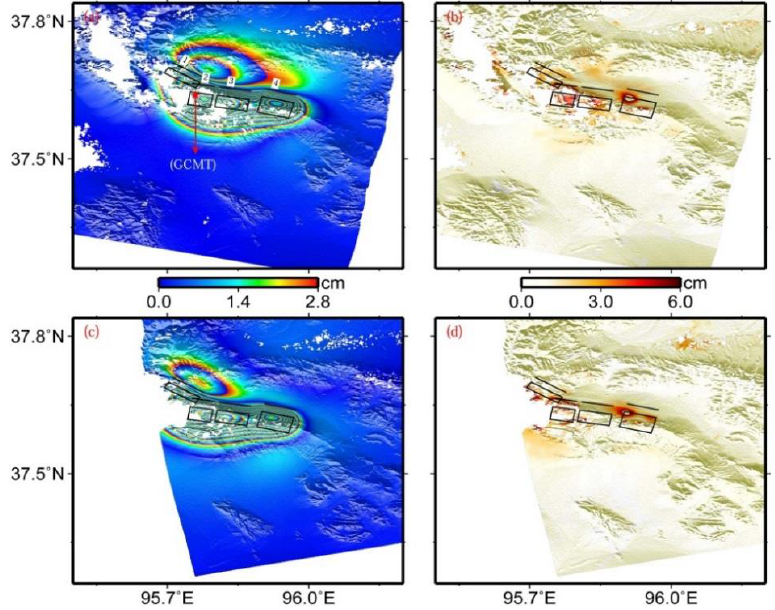
Figure 4. Modeled ( a ) and residual ( b ) interferograms predicted by uniform slip on four rectangular dislocations in an elastic half-space in the viewing geometry for the descending track T319, ( c , d ) for the ascending track T455. From the northwest to the southeast, four black rectangles denote the surface projections of faults 1, 2, 3, and 4 in Table 1, respectively, and black lines for the up-dip projections of the corresponding fault plane to the earth’s